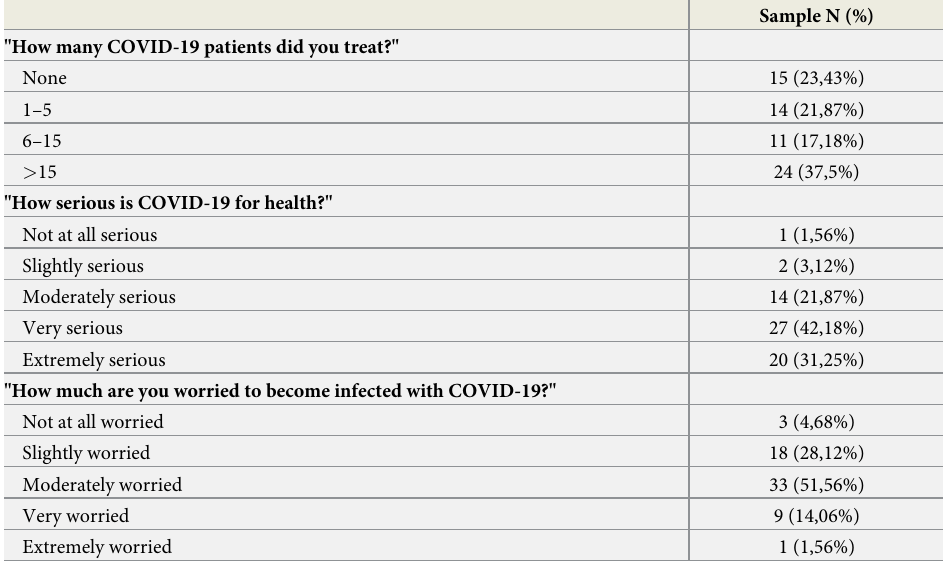
Table 2. Number of responses for each alternative in the COVID-19